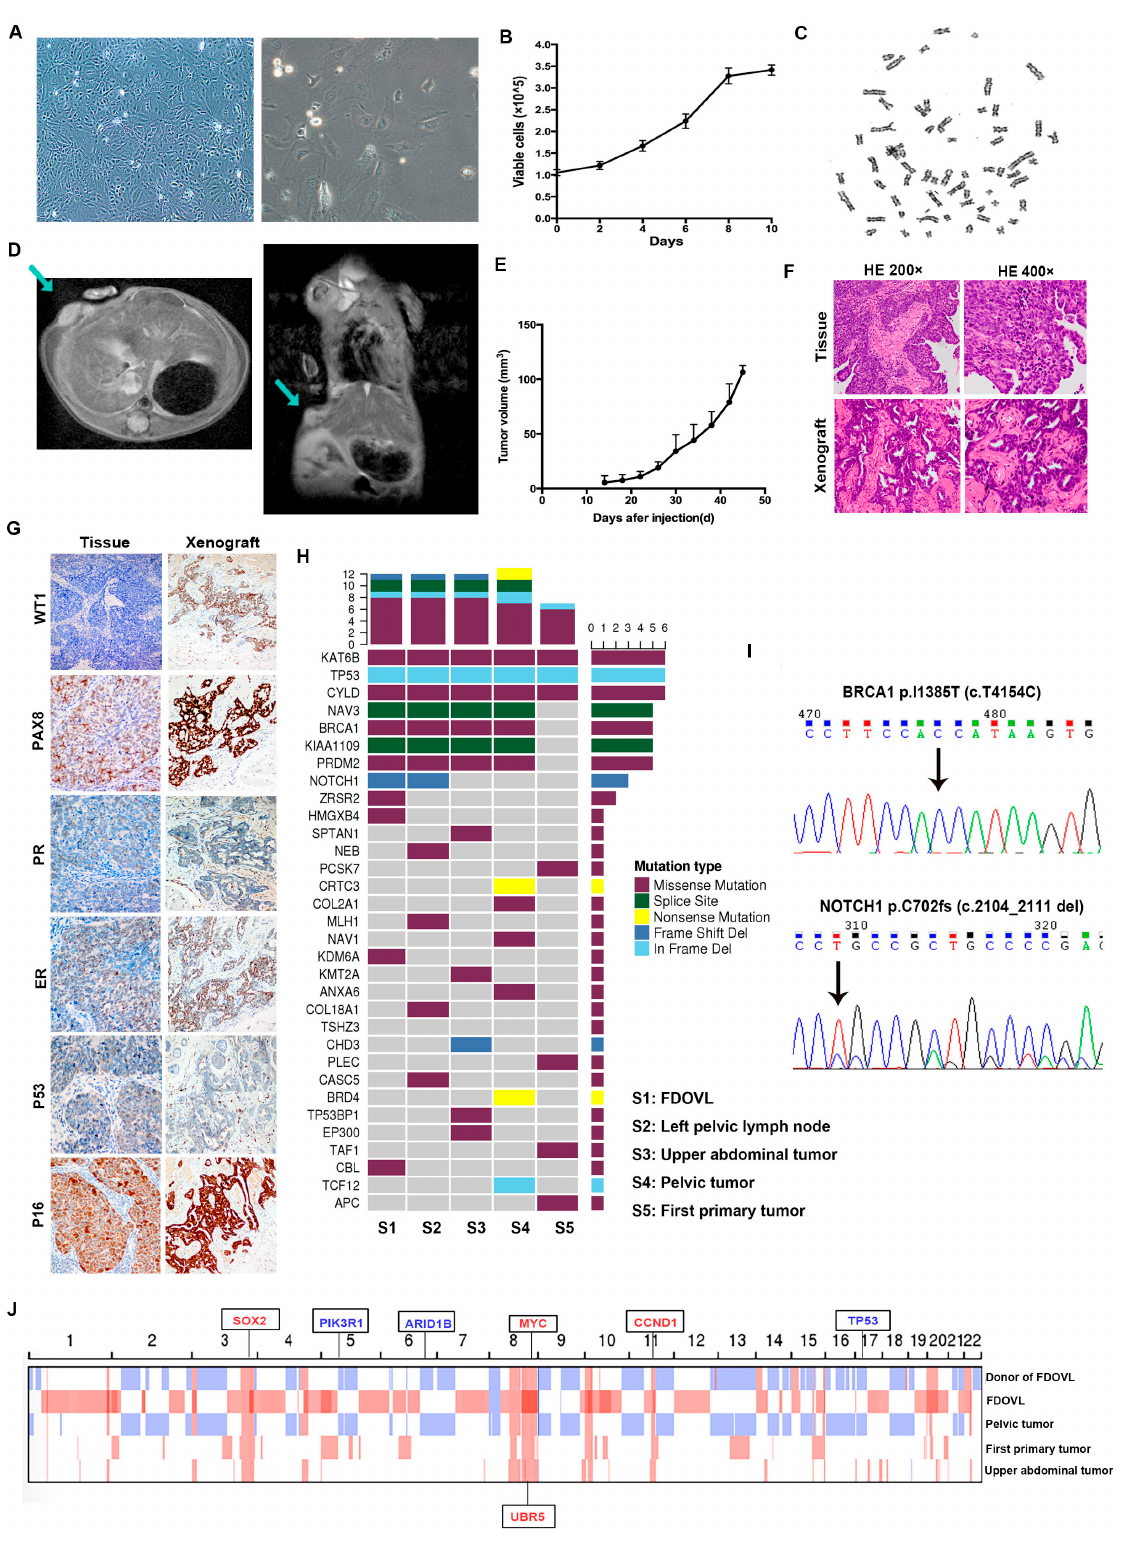
Figure 1. Morphology, growth, and transplantation and genetic characteristics of FDOVL cells. FDOVL cells stably passaged until 32 generation, then were subjected to the detection of general characteristics. ( A ) Phage contrast of microscopy (magnification 100 × and 400 × ). ( B ) The grow curve of FDOVL cells. ( C ) Karyotype of FDOVL cells. ( D – F ) A total of 1 × 10 7 FDOVL cells (32 generations) were used to establish in vivo xenograft tumor models in three nude mice (4 weeks, female).